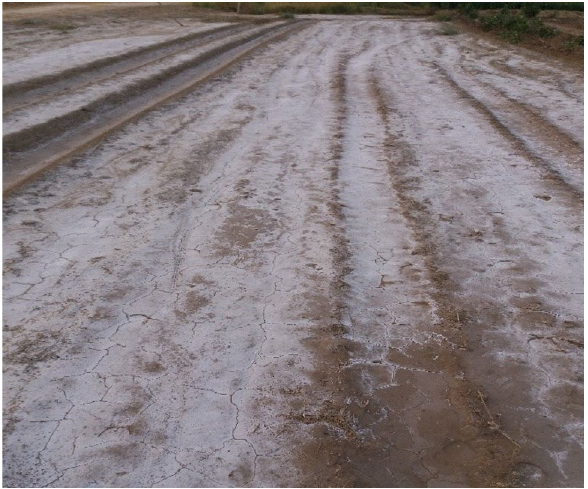
Fig. 6 The experiment area with salts appeared on the